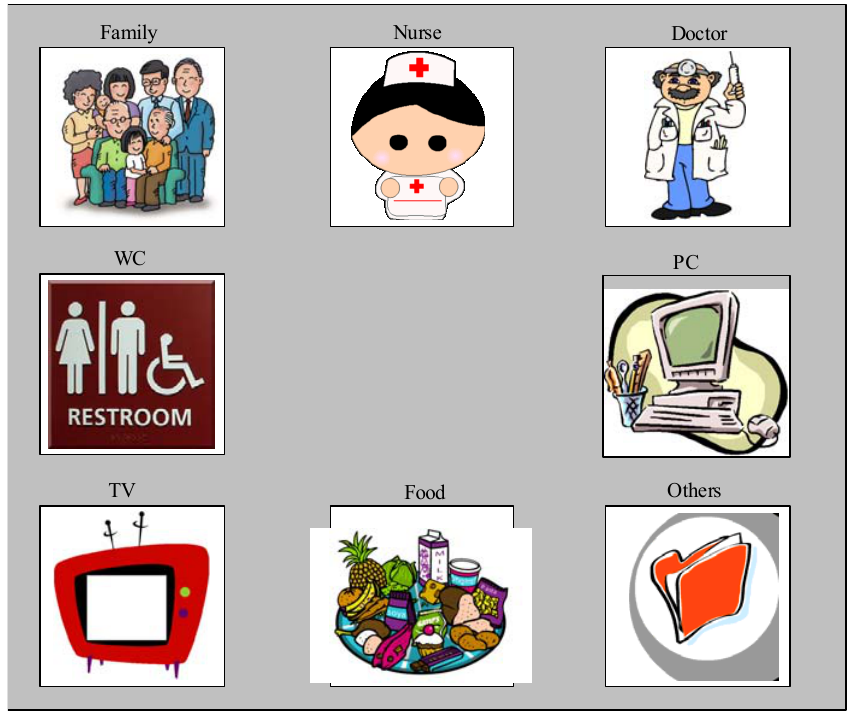
Figure 9. Eight-command interface.